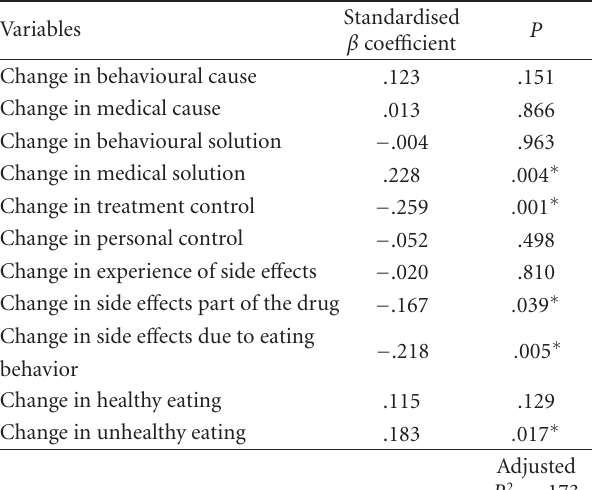
Table 4: Change scores as predictors of improvements in BMI over 6